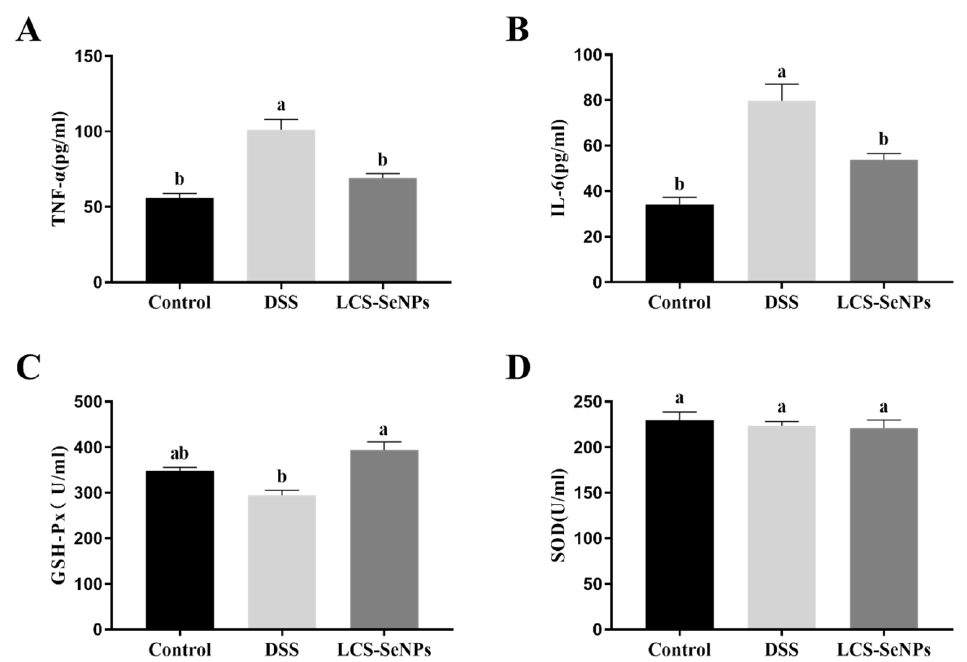
Figure 4. Effects of LCS-SeNPs supplementation on serum inflammation cytokine and antioxidant parameters in DSS-induced colitis mice. The serum inflammation cytokine levels of TNF- α ( A ) and IL-6 ( B ). The levels of GSH-Px ( C ) and SOD ( D ). Data are presented as mean ± SEM. In the same column values with different letters superscripts differ significantly ( p < 0.05).